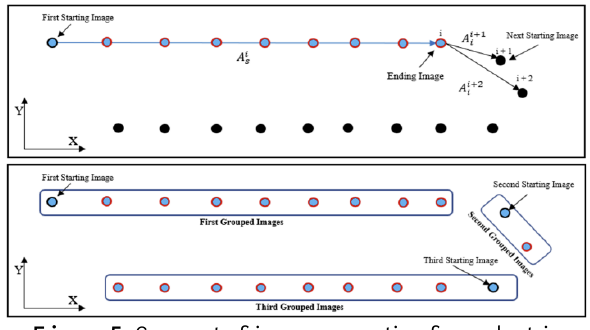
Figure 5. Concept of image separation for each strip (Lim et al.,